Question: Sum up the contents of this chart in one sentence.
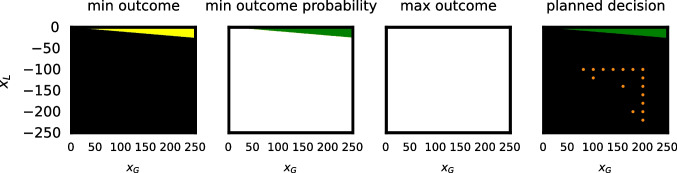
Answer: Predictions of the reference point priority heuristic (RPPH) for the planned decision condition. Notes: Actions are color coded as black: select safe option, green: select risky option, yellow: check next feature, and white: decision made in a previous stage. Orange dots represent gamble outcomes used in Barkan and Busemeyer ( 2003 ). The first three plots represent the internal processes of the RPPHs. The last plot is the predicted planned decision collapsed across stages. \documentclass[12pt]{minimal} \usepackage{amsmath} \usepackage{wasysym} \usepackage{amsfonts} \usepackage{amssymb} \usepackage{amsbsy} \usepackage{mathrsfs} \usepackage{upgreek} \setlength{\oddsidemargin}{-69pt} \begin{document}$$p_{1,2} =.50$$\end{document} for first outcome second stage